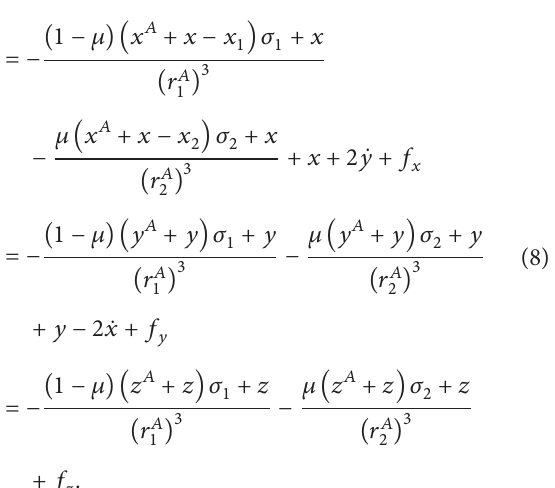
Figure 2: Diagram of libration point orbit spacecraft relative